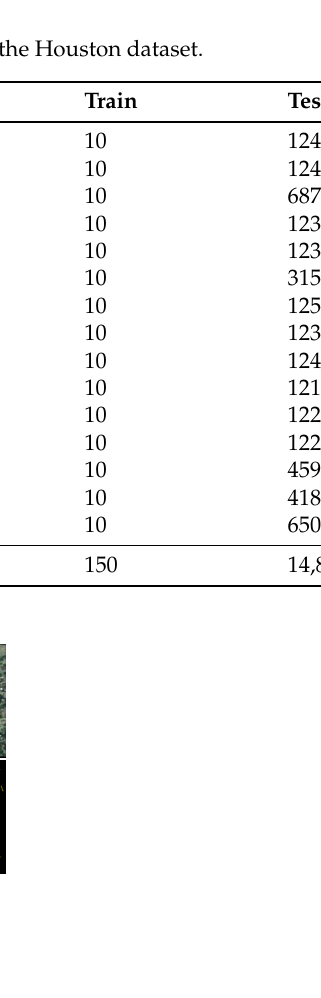
Figure 8. ( Up ) False color image and ( Down ) ground truth map of the Houston